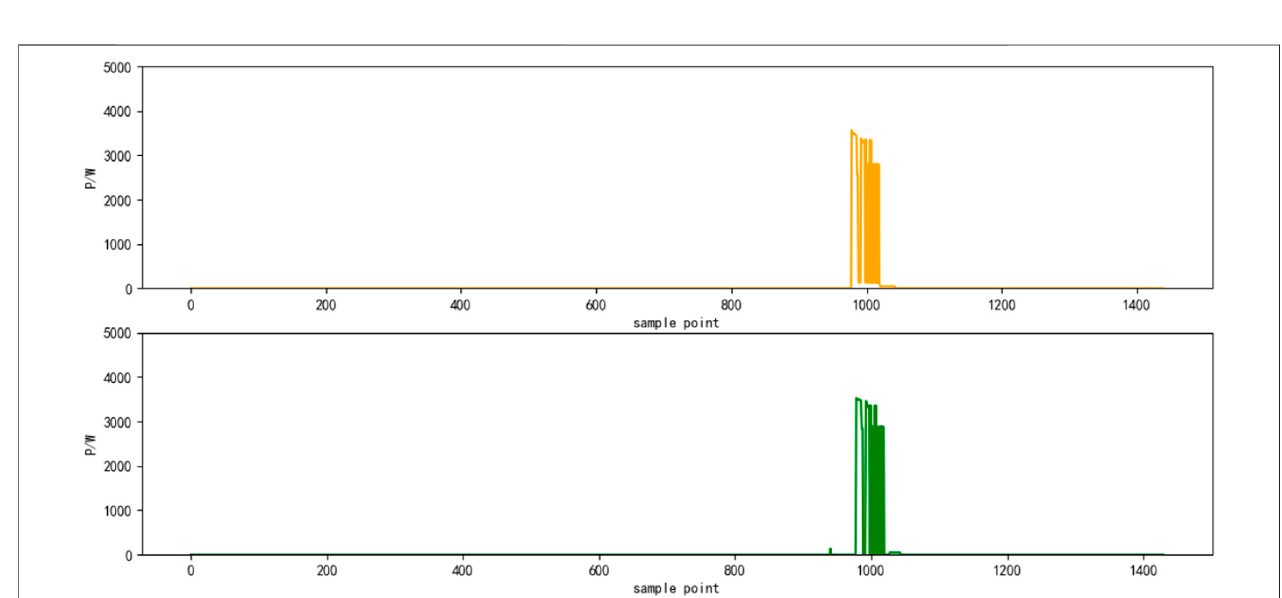
FIGURE 5 | Results of power decomposition